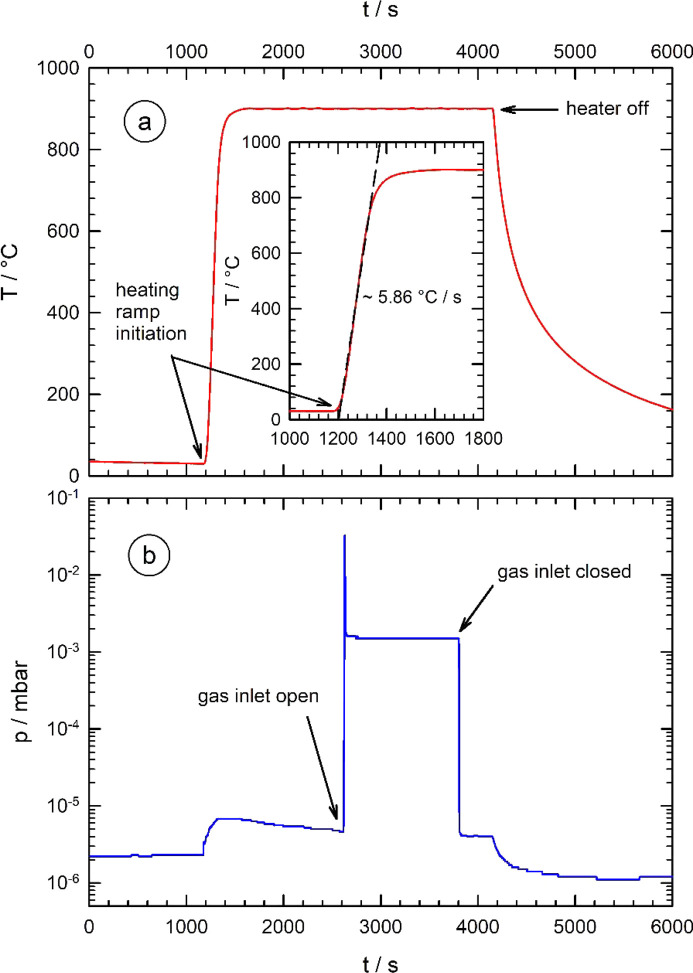
Example of a typical heating process of a niobium metal foil with a well controlled N2 gas exposure in the process chamber, comparable with heat treatments of Nb cavities for accelerating structures. (a) Evolution of the time–temperature program. At t = 1200 s, a heating ramp to T = 900°C was initiated, the temperature was then held for ∼3000 s, until the heater was switched off at t = 4150 s. In the inset, the fit of the temperature increase yields a heating rate of ∼350°C min−1 (dashed black line). (b) Evolution of the vacuum conditions during the heat treatment in (a). After initiating the heating process, the base pressure of ∼2.2 × 10−6 mbar slightly increases during the heat treatment. At t = 2600 s, an N2 exposure at 1.5 × 10−3 mbar was initiated for ∼1200 s. At t = 3800 s, the N2 exposure was terminated, and the base pressure of the cell (p ≃ 1.2 × 10−6 mbar) quickly recovered after switching off the heater at t = 4150 s.